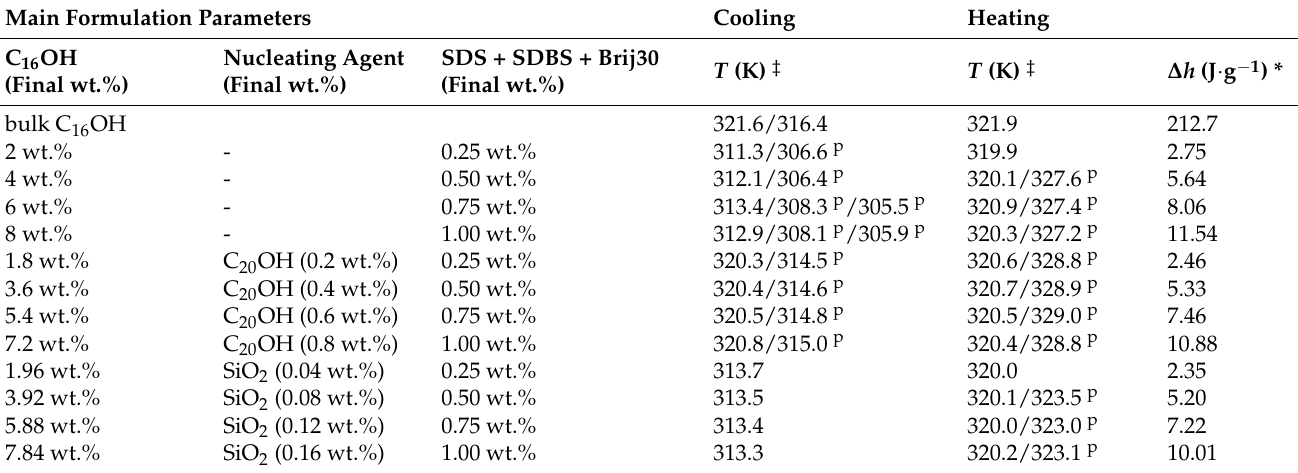
Table 2. Phase change characteristics of bulk C 16 OH alkanol and C 16 OH-in-water emulsions obtained at low scanning rates †